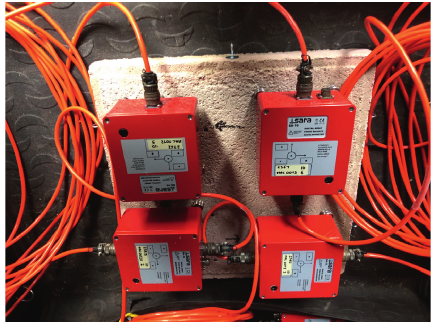
Figure 3: Arrangement of the four force-balance accelerometers used in the experimental